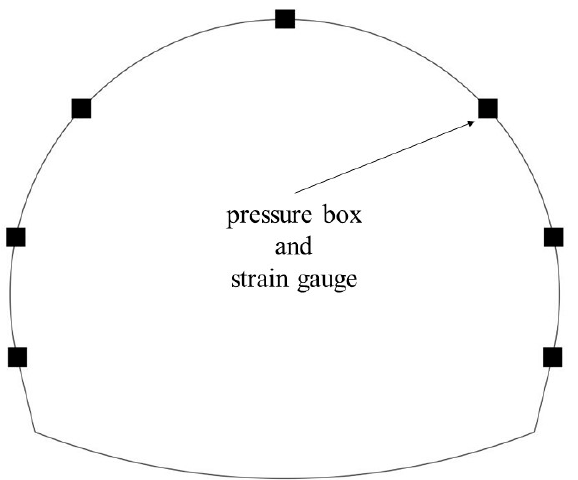
Figure 18. Monitoring points.